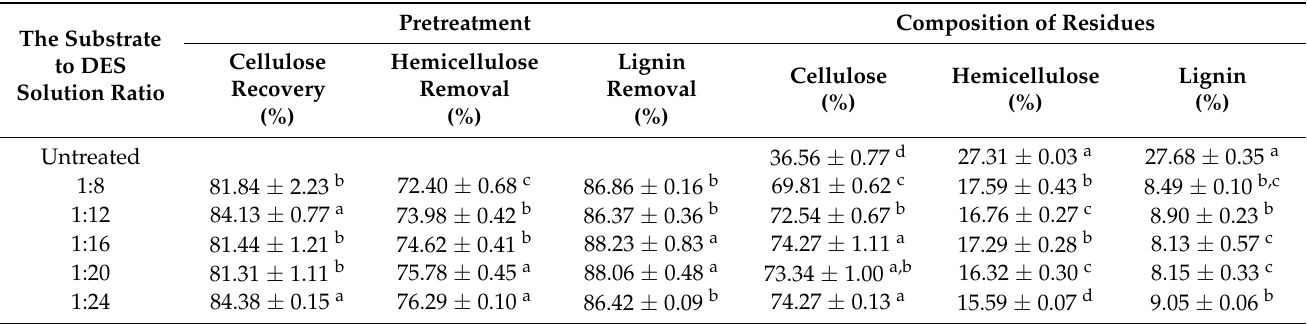
Table 3. Effects of the substrate to DES solution ratio using a 1:6 molar ratio of ChCls/MEA to DES at a temperature of 120 ◦ C and time of 3 h on the pretreatment of sugarcane